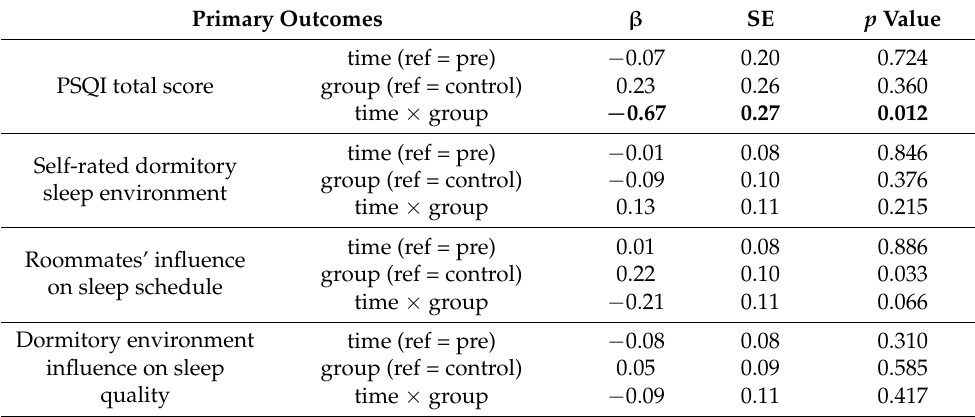
Table 3. Linear mixed-effects models of intervention effect on primary